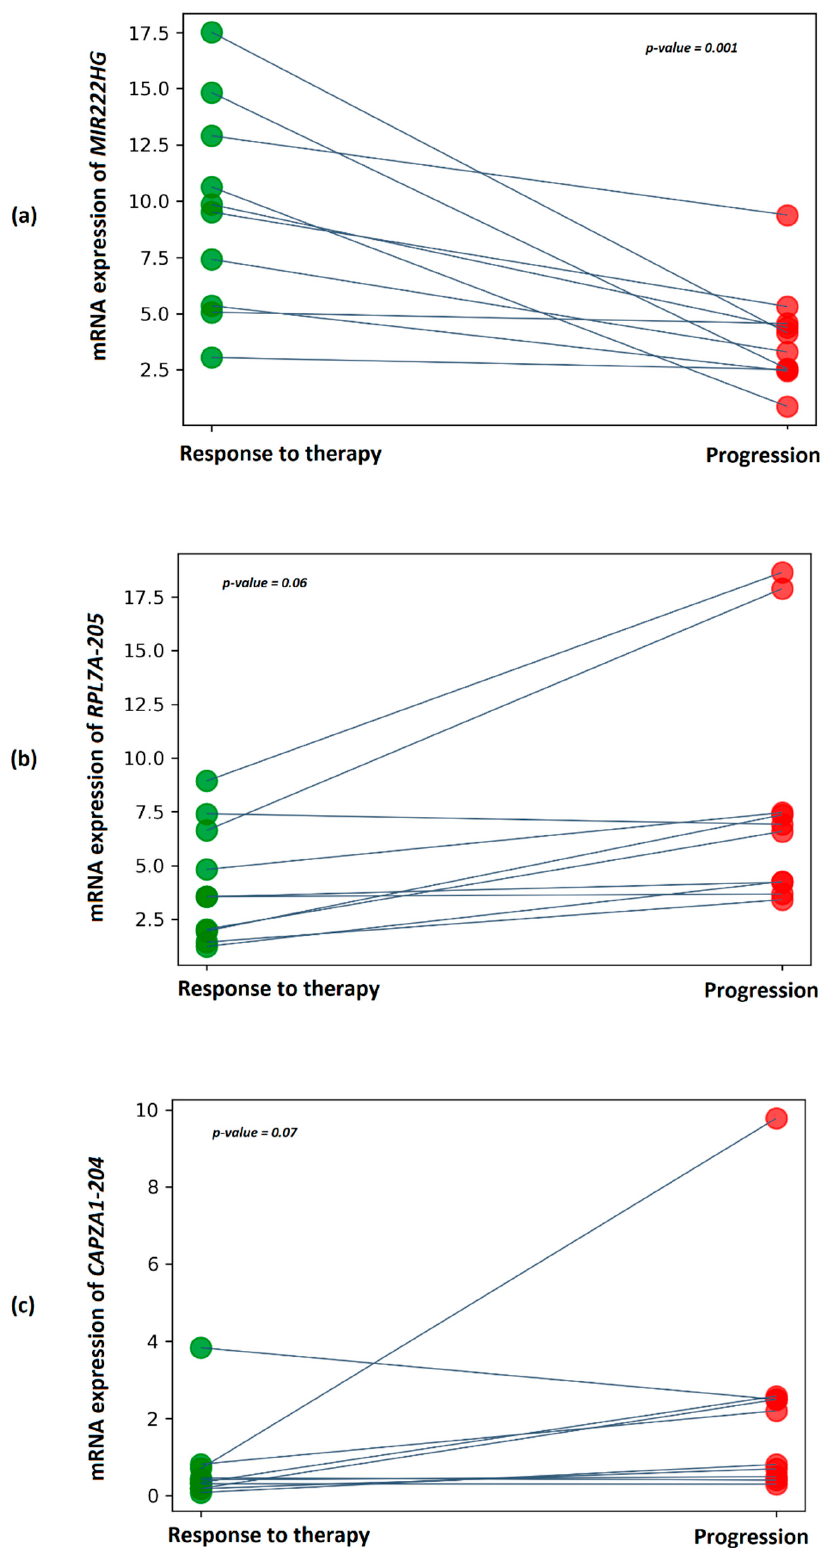
Figure 6. Dot plots showing relative expression results for ( a ) MIR222HG , ( b ) RPL7A-205 , and ( c ) CAPZA1-204 between docetaxel response periods and progression based on plasma exosome samples from patients with CRPC. The y -axis represents the 2ˆ- ∆ CT values. The gray line indicates the direction of relative expression of the transcript between periods for each patient.